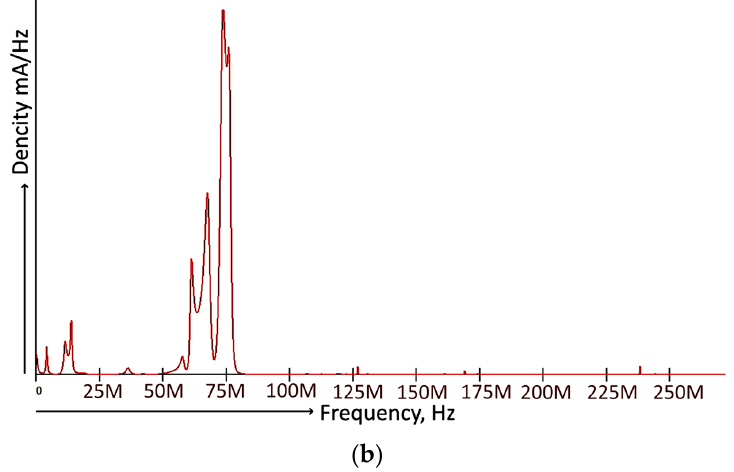
Figure 12. ( a ) Analytical Fourier spectrum of the signal at the output of the Prony spectrum analyzer (relationship between the amplitude spectrum of the signal (density mA/Hz) and frequency, Hz) and ( b ) its energy spectrum.